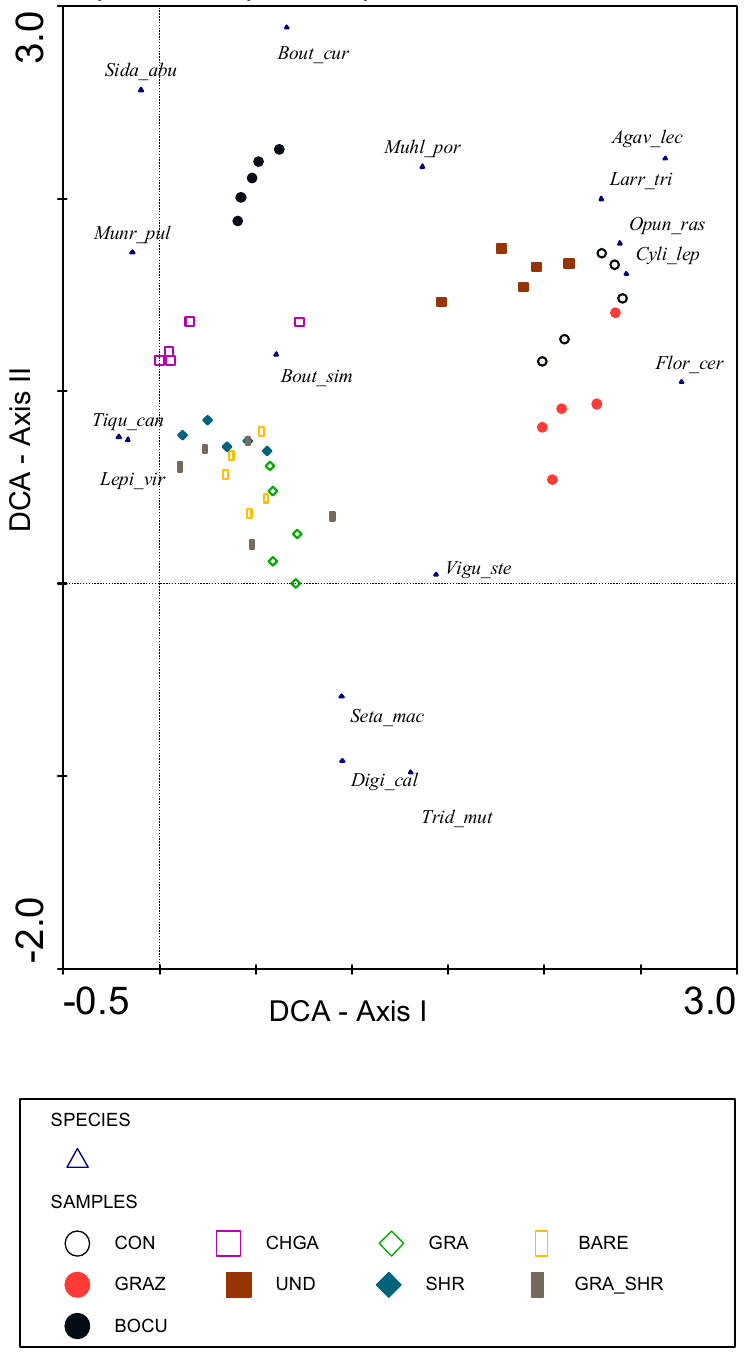
Figure 2. Detrended correspondence analysis axes I and II. Species coordinates and treatments plots coordinates (each treatment with a different symbol). Eigenvalue for axis I: 0.52, eigenvalue for axis II: 0.33, cumulative percentage of total inertia for axes I and II: 53%. Abbreviations for species are: Agave lechuguilla (Aga_lec), Bouteloua curtipendula (Bou_cur), Bouteloua simplex (Bou_sim), Cylindropuntia leptocaulis (Cyl_lep), Digitaria californica (Dig_cal), Flourensia cernua (Flo_cer), Larrea tridentata (Lar_tri), Lepidium virginicum (Lep_vir), Muhlenbergia porteri (Muh_por), Munroa pulchella (Mun_pul), Opuntia rastrera (Opu_ras), Setaria macrostachya (Set_mac), Sida abutifolia (Sid_abu), Tiquilia canescens (Tiq_can), Tridens muticus (Tri_mut), Viguiera stenoloba (Vig_ste) .